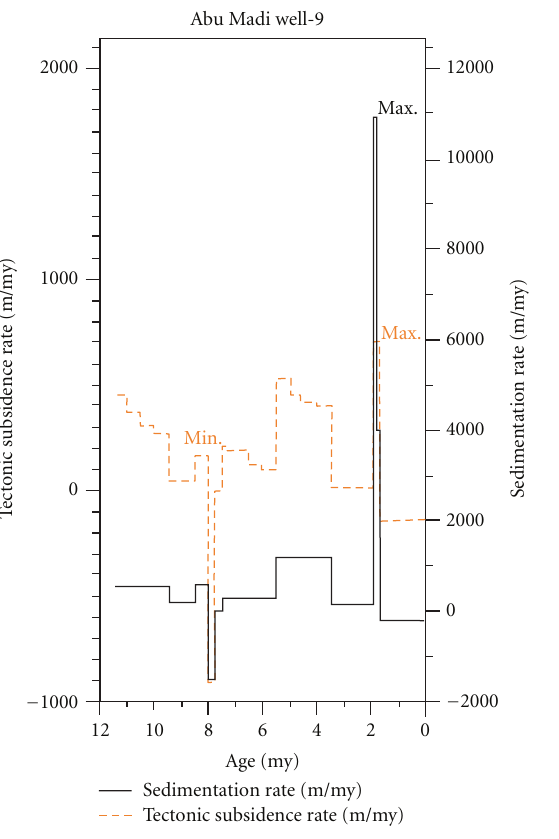
Figure 10: Tectonic subsidence rate for Abu Madi-15 well, showing period of nondeposition and period of increasing rate of subsi-